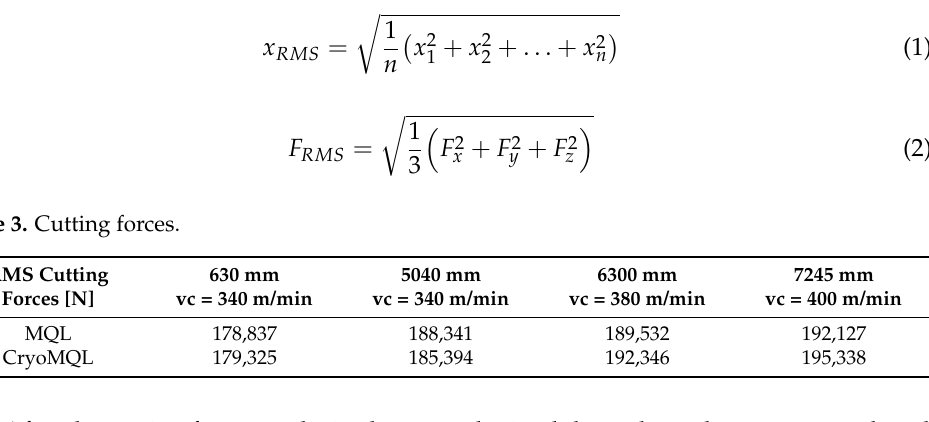
Figure 3. Tool wear. Once tool wear images obtained with the PCE-200 microscope were analyzed, a tool wear analysis was carried out with the SEM microscope to obtain more precise images, verify the materials of which the coating was composed and observe the adhesion in the tool wear area in more detail. Firstly, in Table 4, the tool coating was analyzed and found to obtain Aluminium, Chrorioum, Nitrogen and Titanium, corresponding with manufacturer spec fi cations.